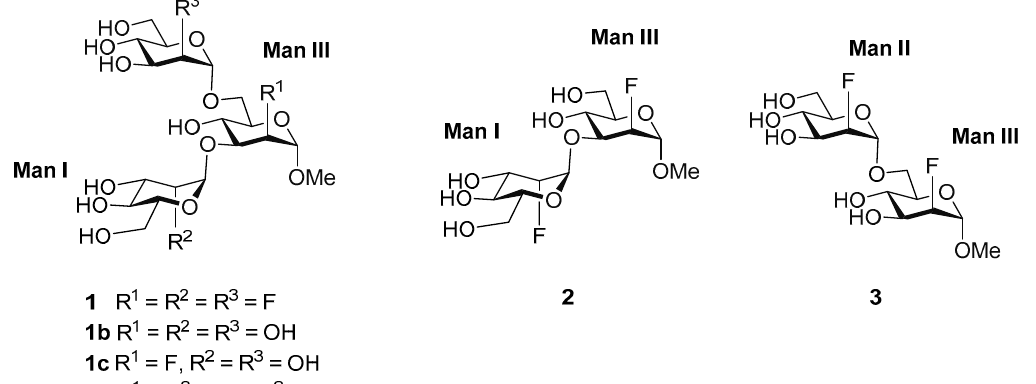
Figure 1. The trifluorinated trisaccharide glycomimetic 1 and its disaccharide components ( 2,3 ). The natural trimannoside core ( 1b ) and related monofluorine-containing glycomimetics ( 1c,1d ) are also shown. The non-reducing terminal residues are labelled as Man I (1 → 3 linkage) and Man II (1 → 6 linkage). The reducing (branched) residue in the trisaccharide is Man III.